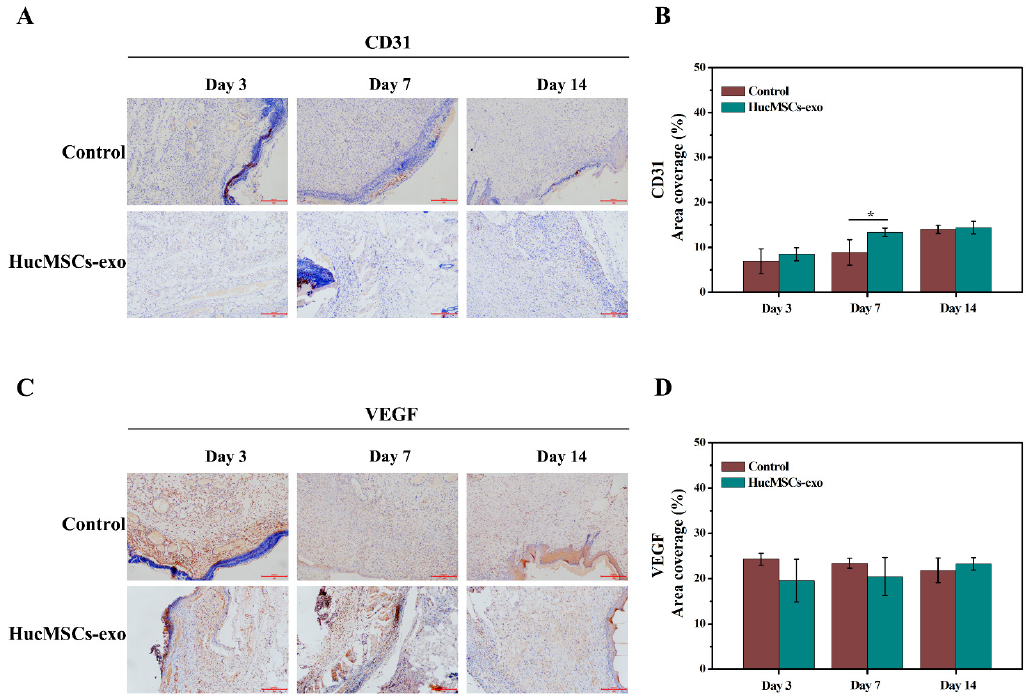
Figure 6. Immunohistochemistry analysis of CD31 and VEGF expression in diabetic wound tissues on days 3, 7, and 14. Representative images of CD31 ( A ) and VEGF ( C ) staining of wound tissues. The scale bar is 200 µ m. Quantitative analysis of the positively stained area percentage of CD31 ( B ) and VEGF ( D ). The data are expressed as mean ± SD (n = 3). * p < 0.05 compared with the control group.